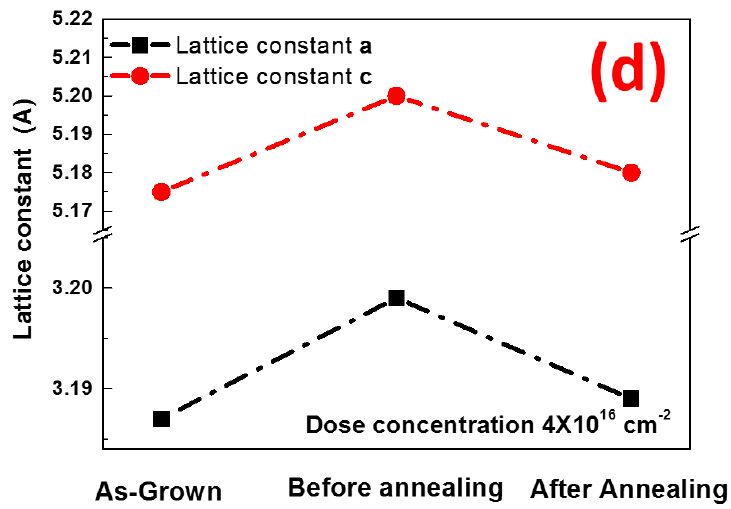
Figure 3. XRD scans of as-grown GaN NW and Co-GaN NW before annealing and after annealing with ( a ) wide range, ( b ) narrow range (002), and ( c ) narrow range (110); ( d ) Calculated lattice constants of a and c for these three samples.